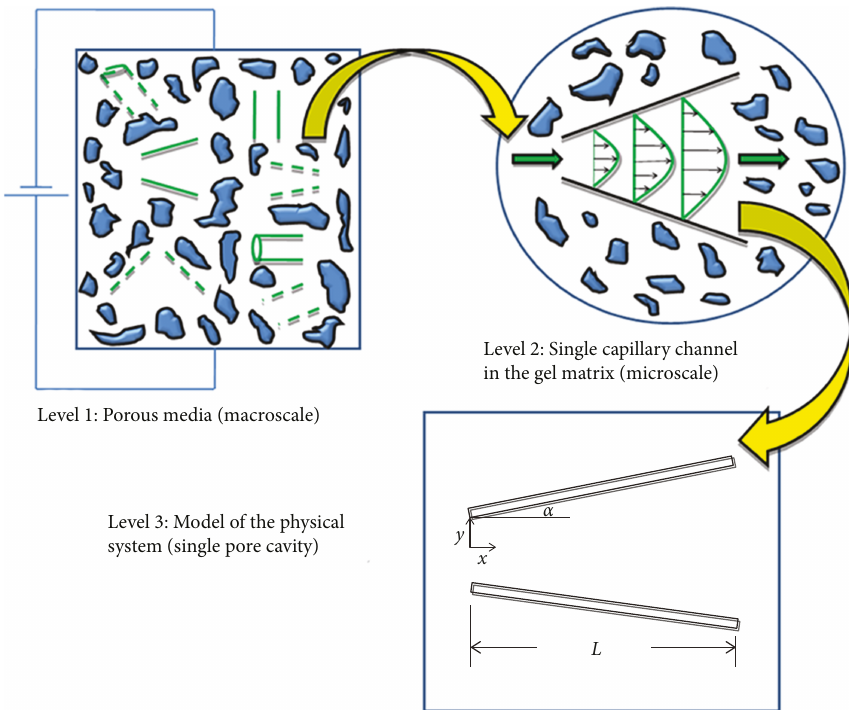
Figure 1: Depiction of the various scales involved in the system under study including a geometrical sketch of the pore and coordinate system used in the